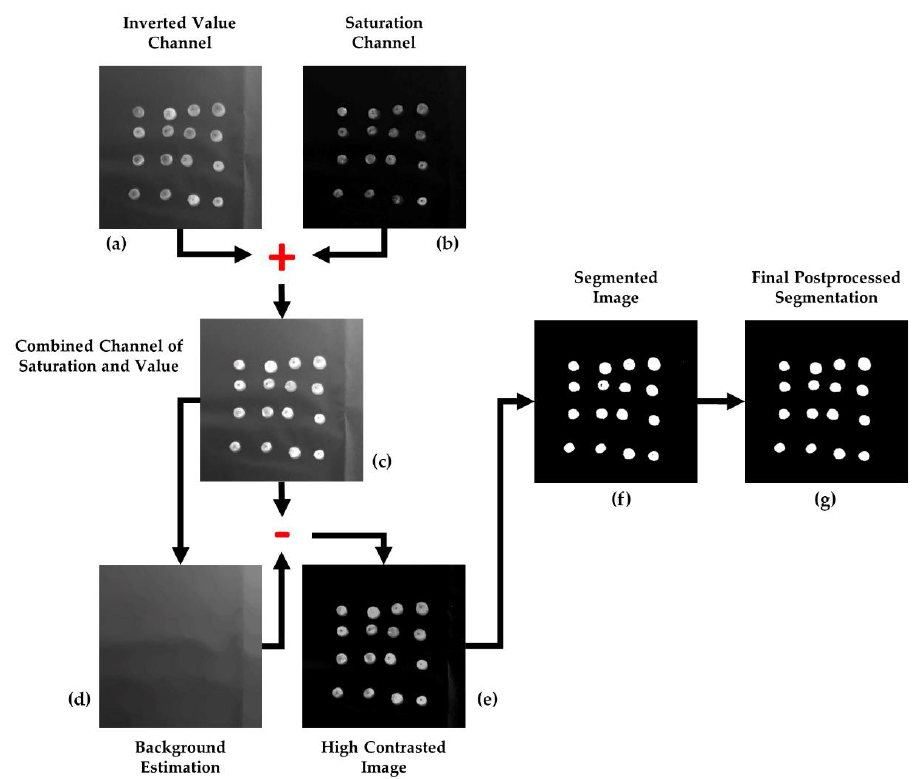
Figure 2. Step by step illustration of the image analysis algorithm on a sub-image of the study set: ( a ) inverted value channel; ( b ) saturation channel; ( c ) combined channel of saturation and value; ( d ) background estimation; ( e ) high contrasted image; ( f ) segmented image; ( g ) final postprocessed segmentation.